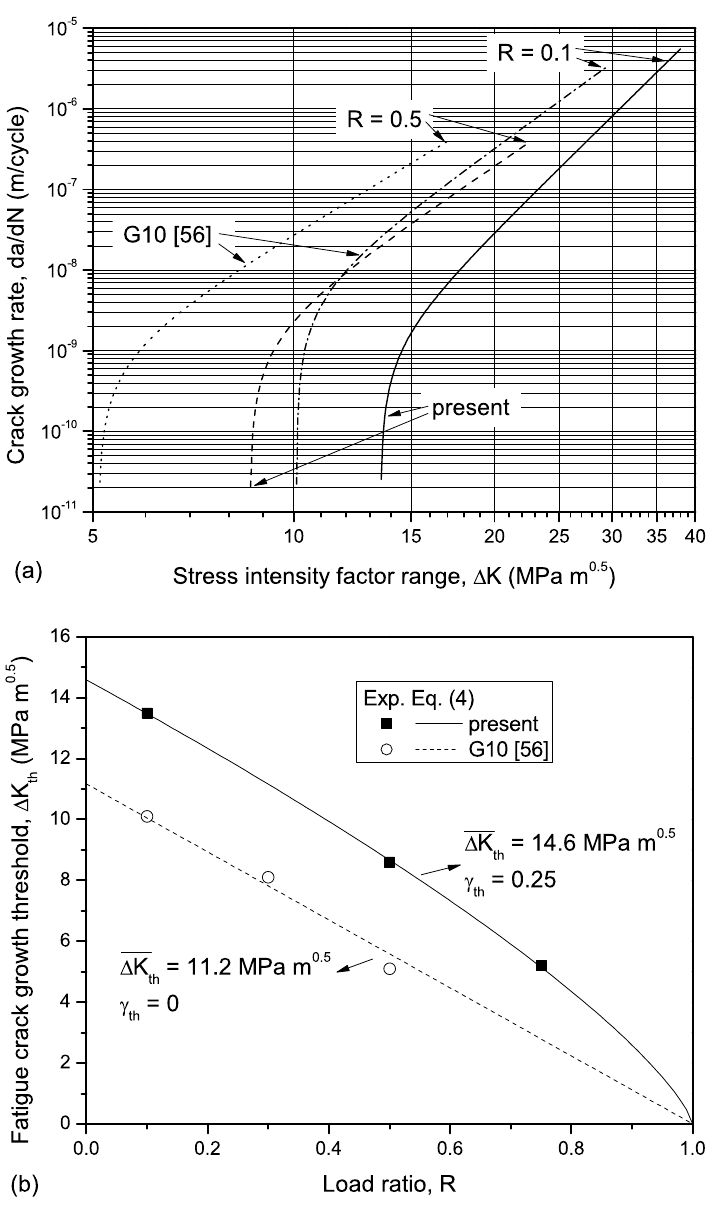
Figure 7. Comparison of fatigue crack growth resistance with data [54] referring to a similar ductile cast iron (DCI) subject to normal solidification conditions: ( a ) d a /d N - ∆ K curves; and ( b ) threshold dependency upon load ratio R .